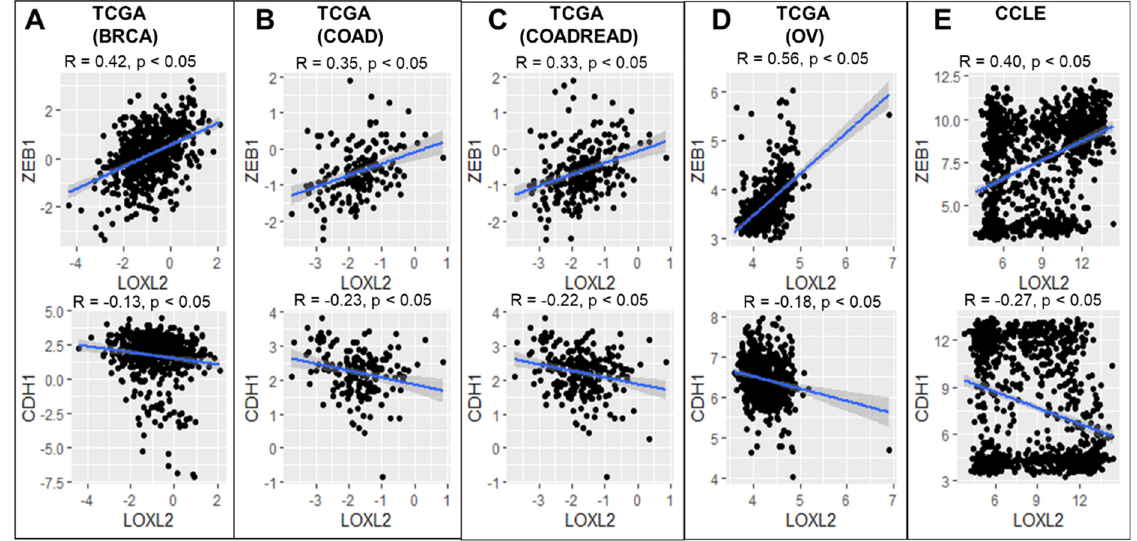
Figure 1. Correlation between EMT markers and LOXL2 gene expression values. ( A – E ) represent the results for different cancer types. Pearson’s correlation values (R, p) have been included; the regression line has been highlighted in blue.